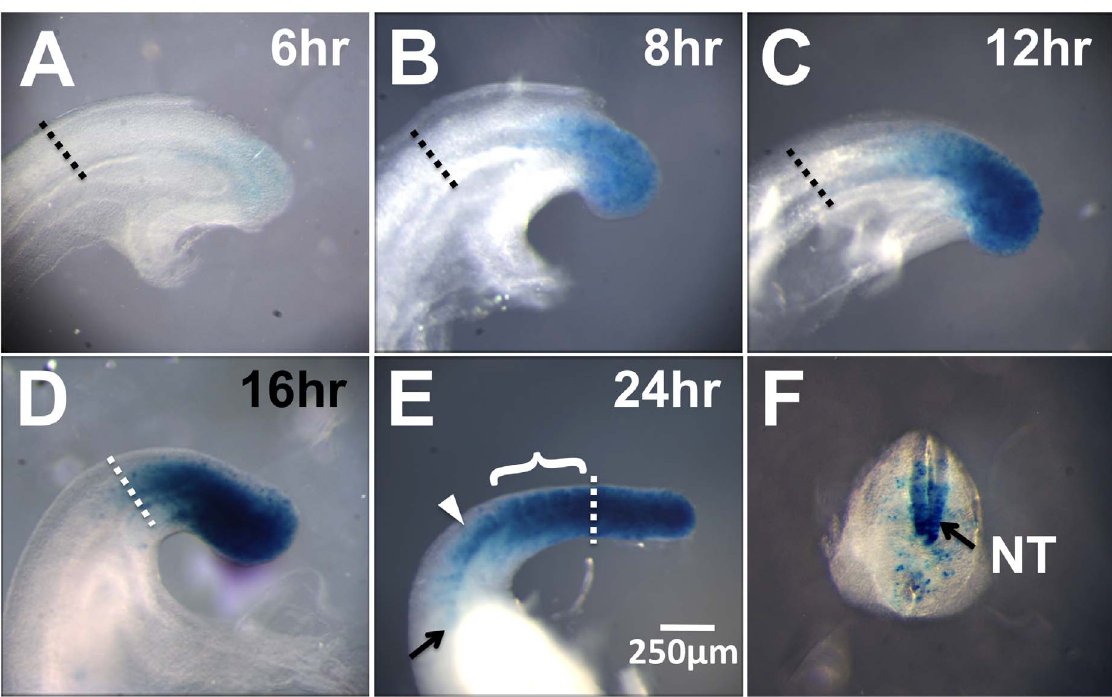
Figure 3. TCreERT2 recombination dynamics allows measurement of the invivo rate of axis extension and somitogenesis. A single dose of tamoxifen was injected at 8:00 AM to dams carrying an E9.0–E9.5 TCreERT2; R26R litter. After the indicated time interval, embryos were harvested and stained for ßGal activity ( A–E ). The dotted line in all panels marks the border between the anterior PSM and the most caudal somite. After 6 hours, blue cells can just be discerned ( A ). The intensity of blue increases progressively by 8 hours ( B ) and 12 hours ( C ), indicating an increase in the fraction of recombined cells. By 16 hours, the recombined domain has reached the border between the anterior PSM and youngest somite ( D ). Over the next 8 hours, the four most caudal somites (bracket in E ), which together measure approximately 470 m m, are heavily labeled (24-hour point , E ) demonstrating that, at this stage, the embryo is extending about one m m/min (470 m m/480 min) and a somite forms about every 2 hours. In the lateral view in E it appears that somites rostral to the bracket are labeled (i.e, there are more than 4 blue somites), but this is an illusion due to viewing a blue labeled neural tube (NT) through translucent, mostly unlabeled, somites. This is demonstrated by a transverse view, shown in panel F , of the embryo in E (white arrowhead E indicates where embryo was